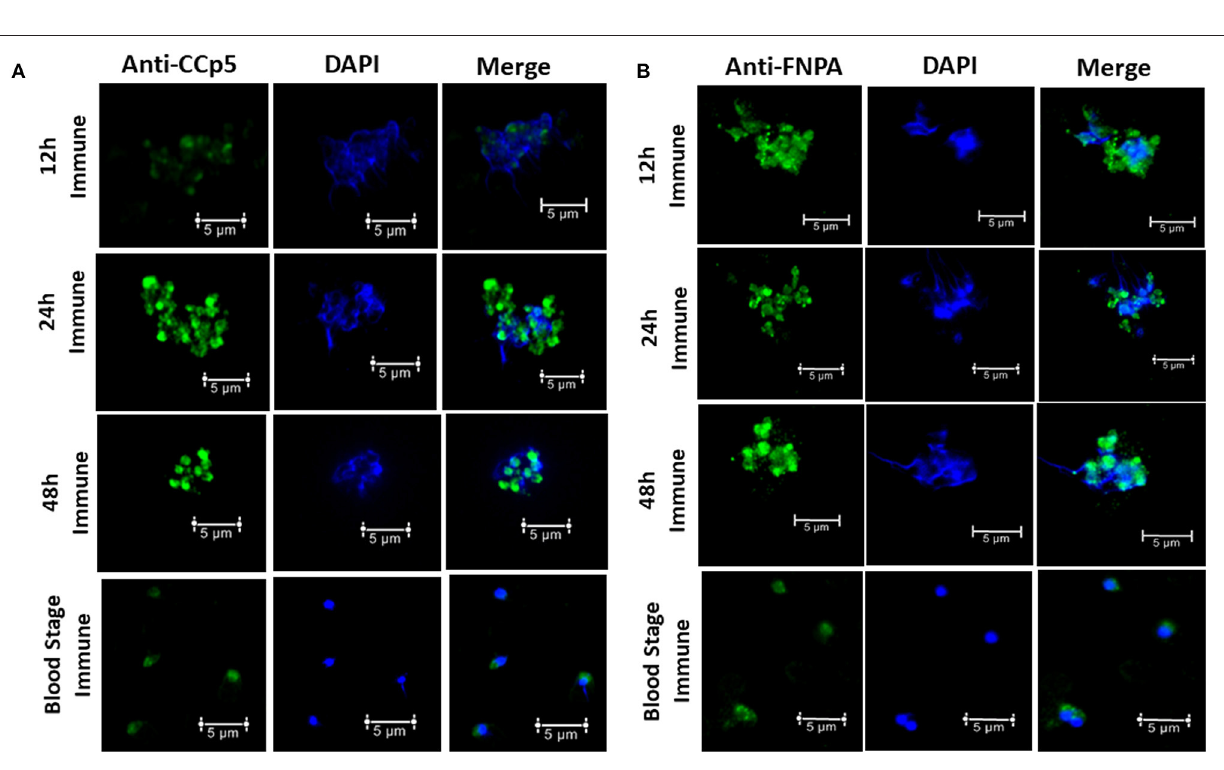
FIGURE 7 | Immunofluorescence assays demonstrating the expression of CCp5 (A) and FNPA (B) in blood stage and in vitro induced sexual stages (12–24–48h) of B. bovis